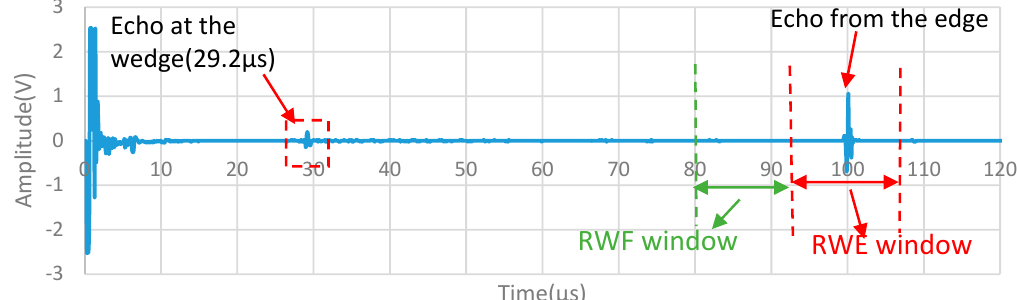
Figure 4. The entire signal received for the empty container, including the selected windows for the reflection from the liquid and the reflection from the edge.